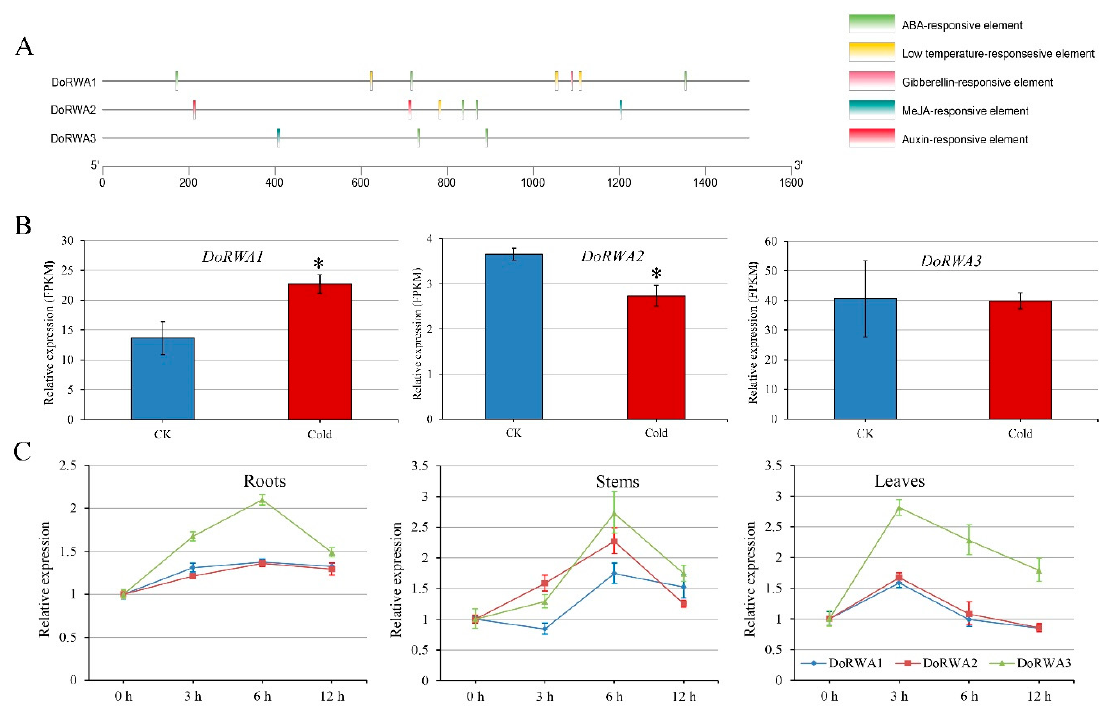
Figure 3. Analysis of cis -elements and relative expression levels of three DoRWA genes under cold stress (4 °C) and abscisic acid (ABA), (100 μ M) treatment. ( A ) Analysis of cis -elements in the promoter region of three DoRWA genes. Different colors represent different cis -elements. ( B ) Relative expression level of three DoRWA genes under CK (20 °C) and cold stress (4 °C) using the FPKM value. ( C ) Relative expression level of three DoRWA genes in the ABA treatment. The transcript level of DoRWA genes at 0 h was set as 1. Each data bar represents mean ± SD ( n = 3). * indicates p < 0.05 between the expression level of three DoRW A genes in CK and cold treatment according to Duncan’s multiple range test (DMRT).